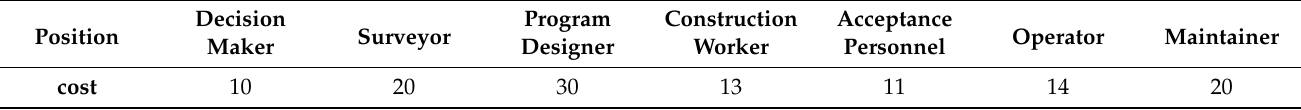
Table 3. Initial training cost list.